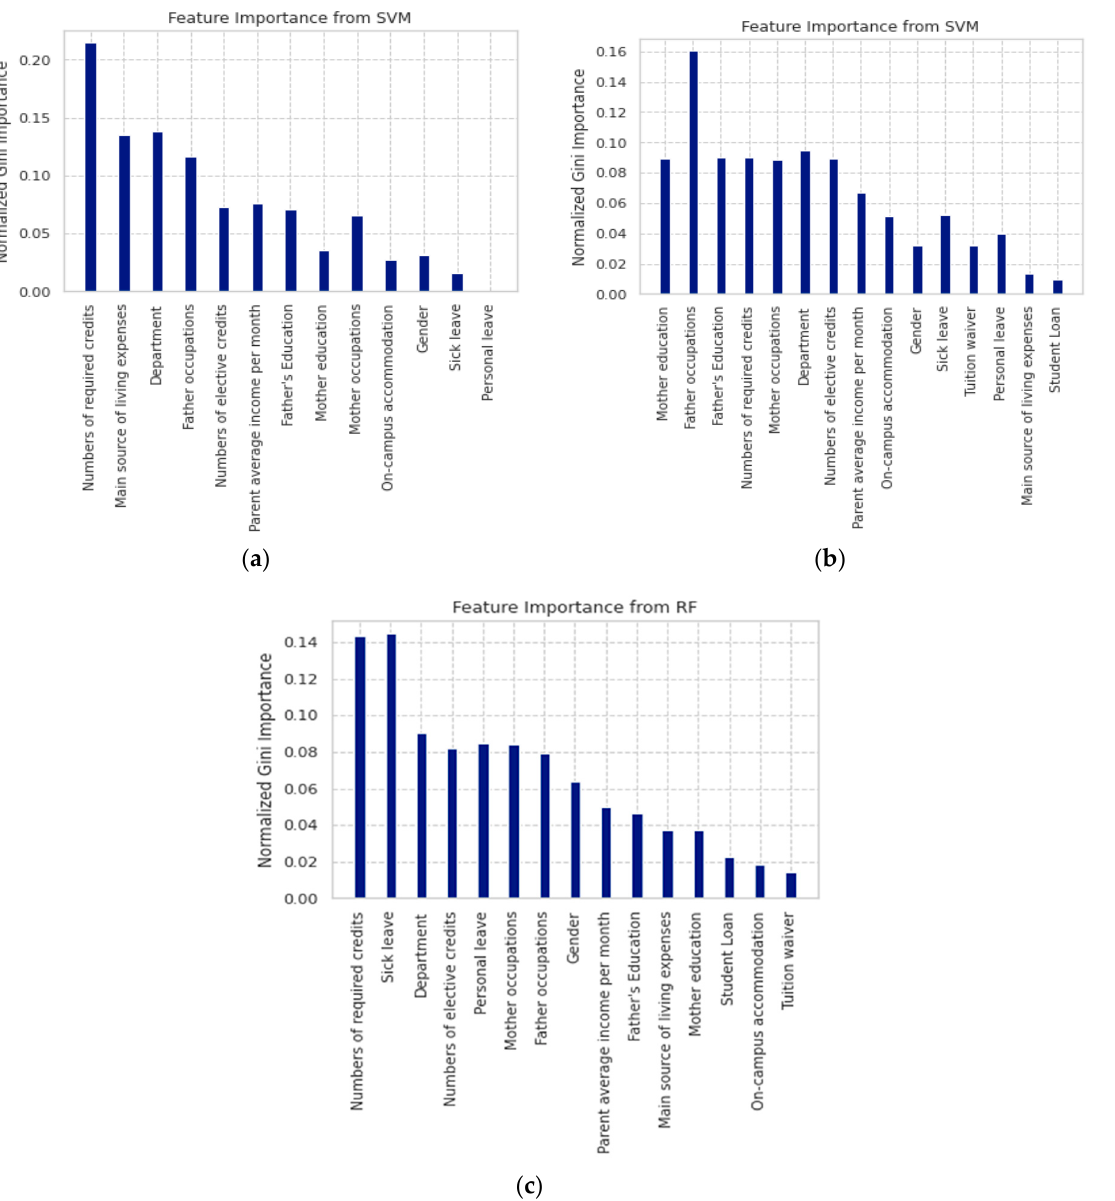
Figure 6. Gini feature importance: ( a ) Group 1: from SVM; ( b ) Group 2: from SVM; ( c ) Group 3: from RF. Table 9. The seven top-ranking important features associated with learning performance of three groups of